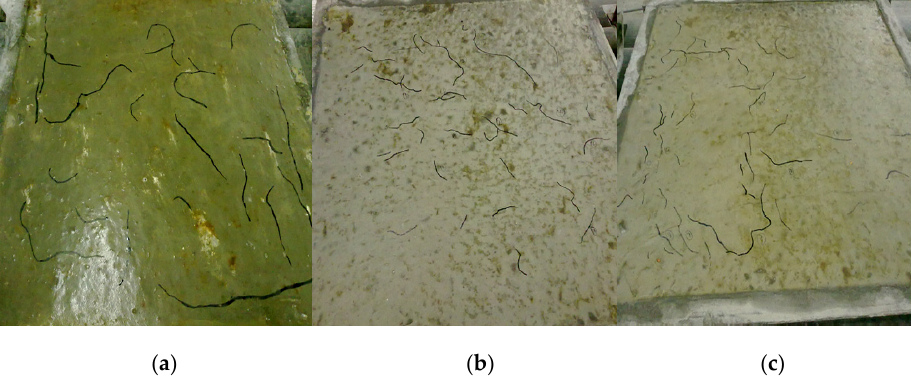
Figure 9. Crack morphology of some specimens after (Tcr + 27.5) hours (activated FACs). ( a ) FA ‐ 40%, AC ‐ 1.0%; ( b ) FA ‐ 40%, AC ‐ 1.5%; ( c ) FA ‐ 40%, AC ‐ 2.0%.